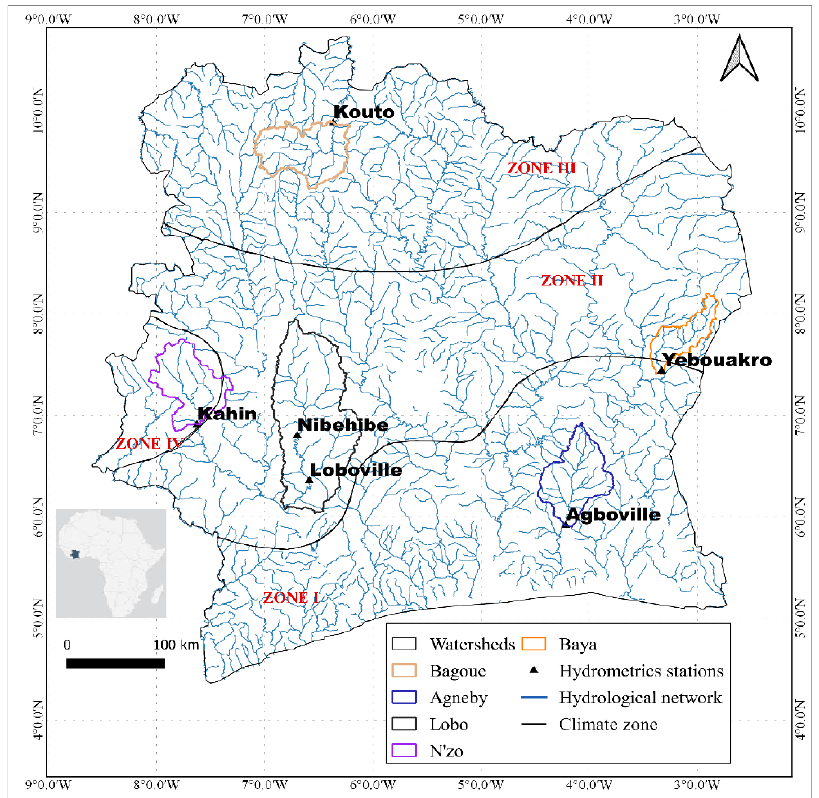
Figure 1. Locations of the five selected watersheds within the different climatic zones in Côte d’Ivoire.